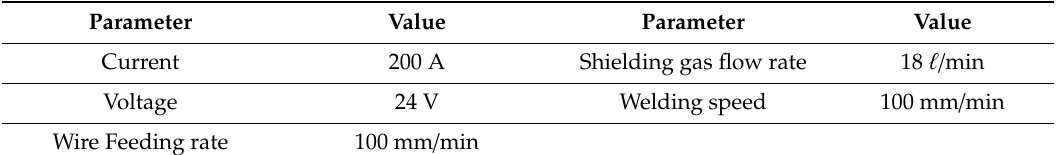
Table 3. Welding Table 3. Welding parameters.